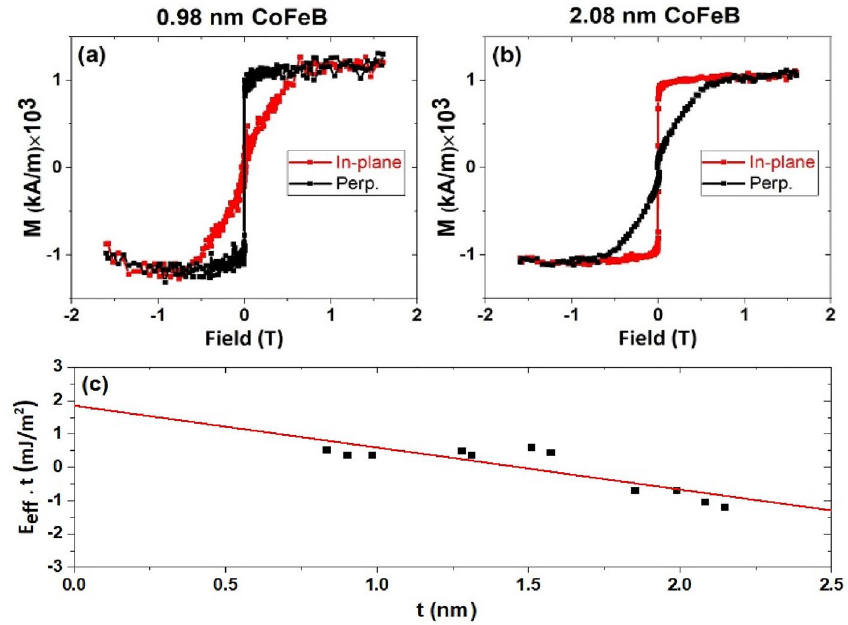
Figure 1. ( a ) and ( b ) Hysteresis loops of the samples with CoFeB thicknesses of 0.98 and 2.08 nm, respectively. The samples were annealed at 300 °C for 10 min. ( c ) The plot of E eff · t as a function of the CoFeB thickness t in a series of